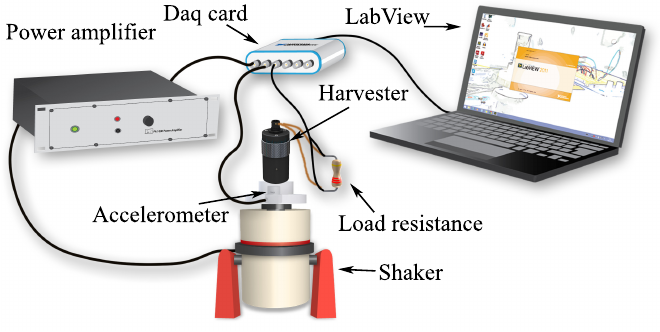
Figure 3. Schematic of the experimental setup.